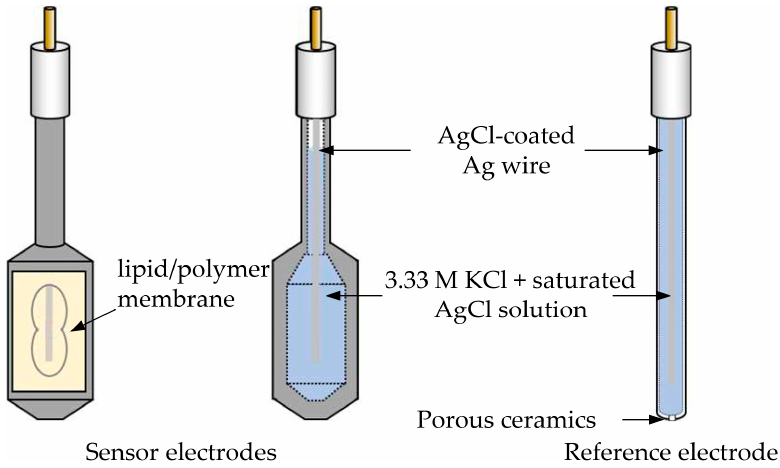
Figure 2. Structure of sensor and reference electrodes.